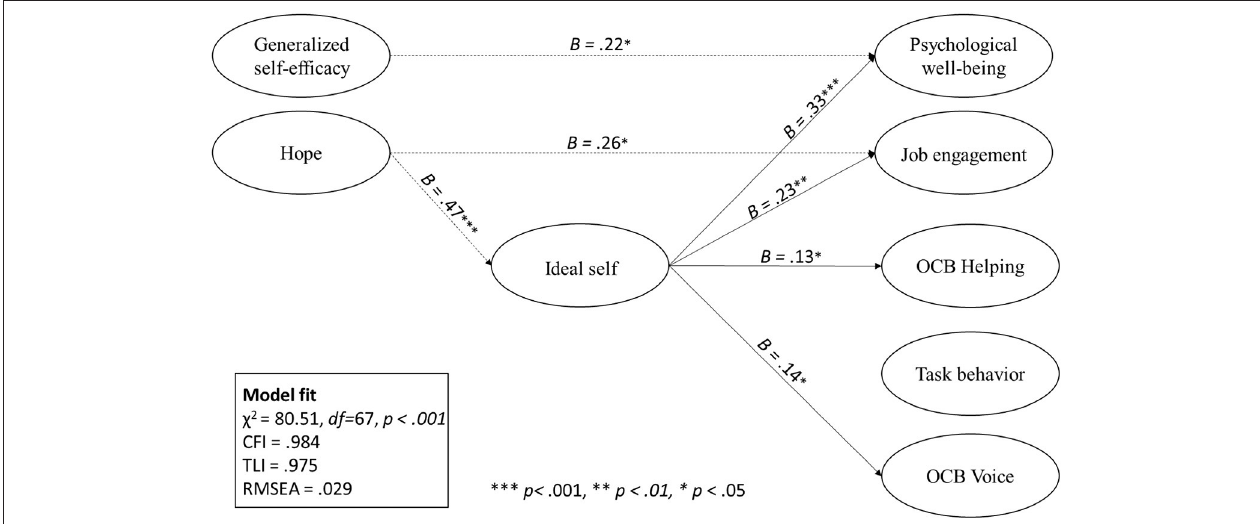
FIGURE 1 | Final model showing significant paths. Demographic control variables not shown for simplicity include age, gender, company, years in company, education, number of raters, ratio of male to female raters, and rater’s years in